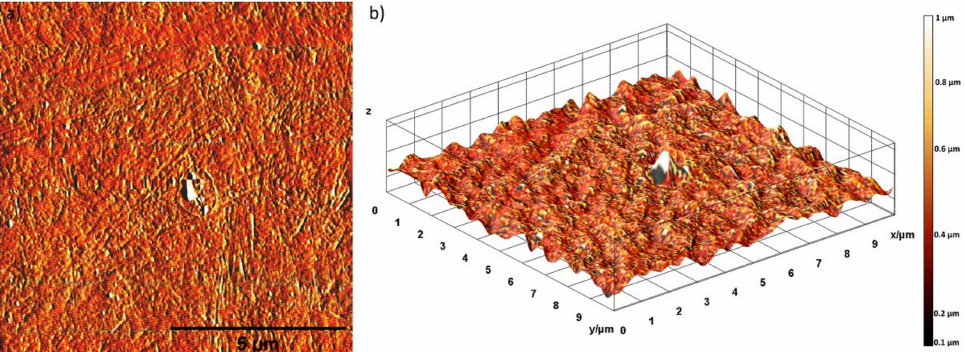
Figure 7. Topographical images of HApFe coatings ( a ) obtained using AFM and 3D representations of the topographical images of HApFe coatings ( b